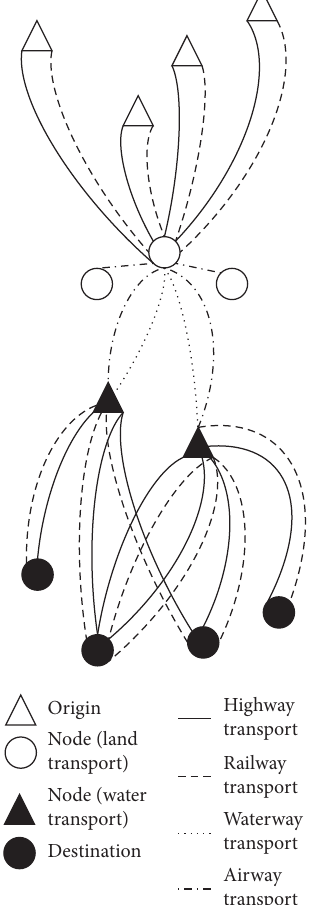
Figure 1: Freight paths of the multimodal transport